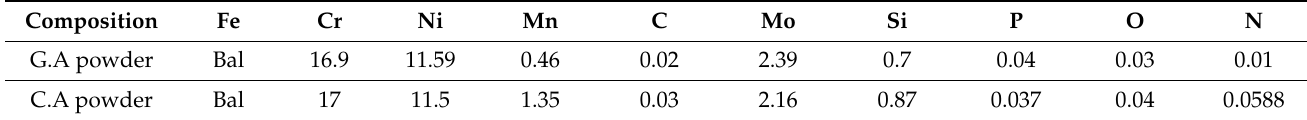
Table 1. Chemical composition of powders used for cold spray.